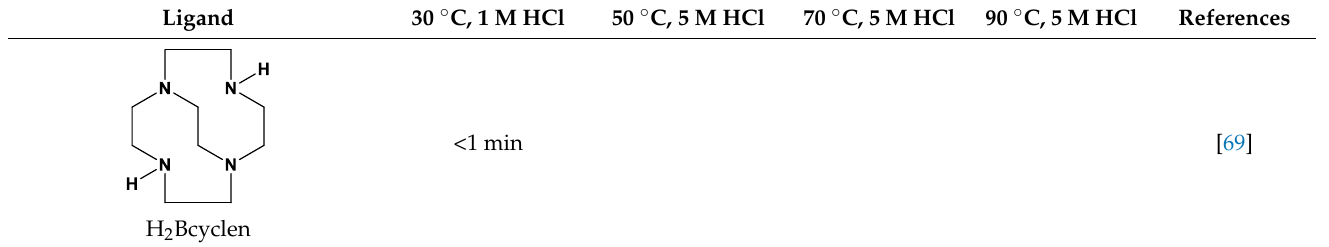
Table 4. Pseudo-first-order half-life for acid decomplexation of Cu 2+ complexes under harsh conditions.